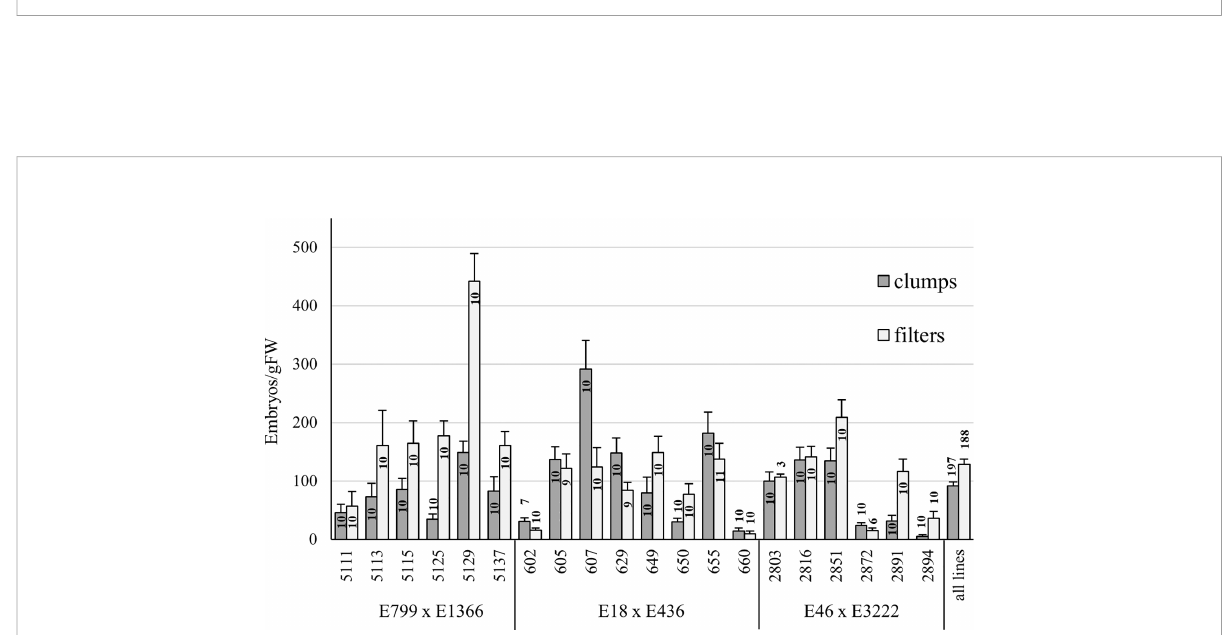
FIGURE 3 Embryo yield from Trial III, comparing ET proliferated on fi lter discs or as clumps. Mean embryo yield and standard error of the mean for a line and overall are presented. The number of plates (n) for each line in each treatment is presented inside each bar.